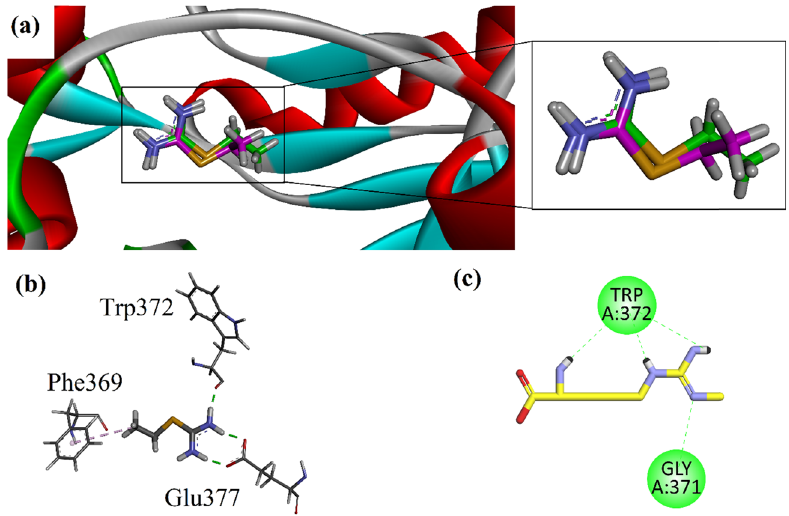
Figure 2: ( a ) Ribbon superposed model of native ITU ( green carbon stick ) and re - docked ITU ( pink carbon stick ) ; ( b ) 3 - D interaction plots of native ITU in the binding site of iNOS ( PDB ID = 4NOS ) ; and ( c ) 2 - D interaction plot of control drug N G monomethyl L - arginine in the binding site of iNOS. These 3 - D/2 - D interactions plots are modeled by using Discovery Studio Visualizer.